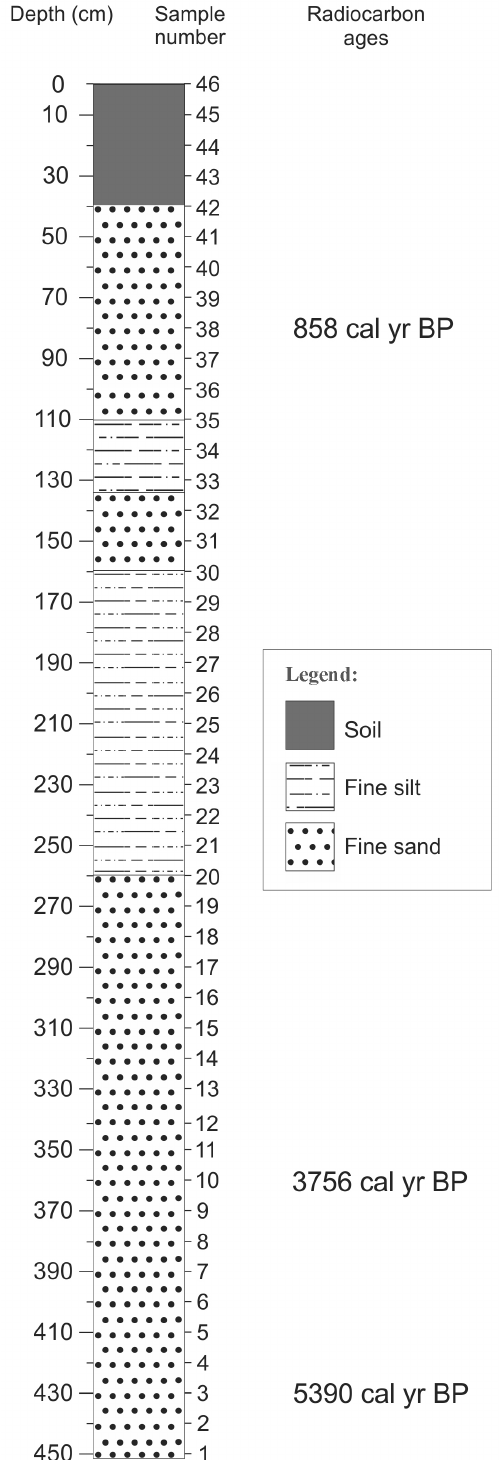
Figure 2 - Schematic sedimentar column of the PCSC- 3 core showing the grain size variation, location of samples extracted for palynological analyses.